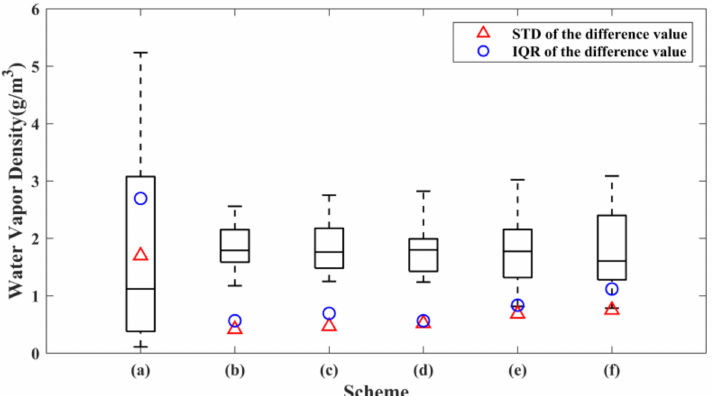
Figure 5. Box plots of the difference value of mean water vapor density between two adjacent stratifi- cations derived from the six stratification schemes, where ( a ) derived from uniform stratification; ( b – f ) derived from ANES with minimum height intervals of 350, 375, 400, 425 and 450 m,